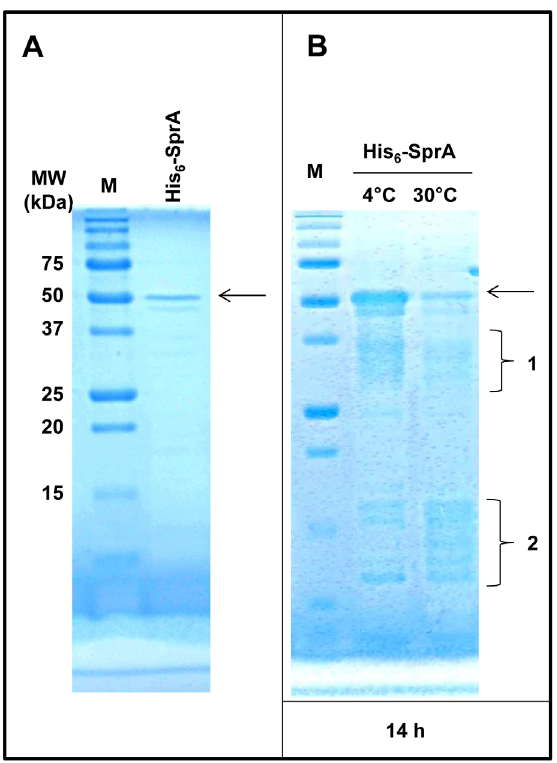
Figure 4. Purification and self-proteolysis of SprA. Purified His 6 - SprA (A) was incubated at 4 u C or 30 u C for 14 h as described in the Materials and Methods (B). The arrows indicate purified His 6 -SprA. The self-proteolysis of His 6 -SprA is shown in brackets 1 and 2 of B. M, molecular weight marker.